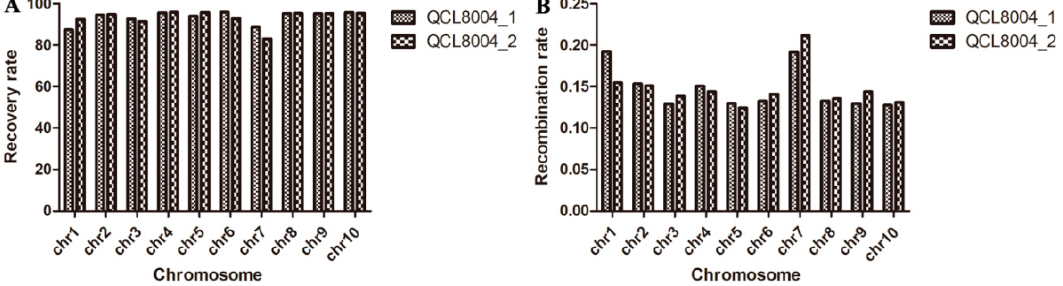
Figure 2. The background recovery rate ( A ) and recombination rate ( B ) of QCL8004_1 and QCL8004_2 in ten